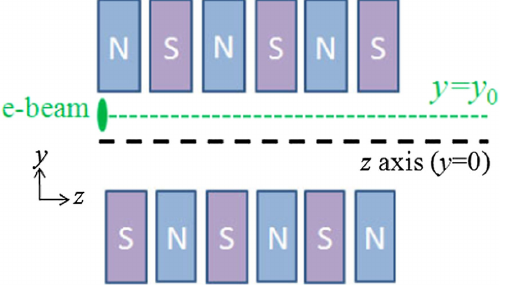
FIG. 1. Illustration for using the natural transverse gradient of a normal undulator to overcoming the effect of large energy spread by deviating the electron beam orbit of y 0 . The electron beam is previously dispersed in the vertical direction.